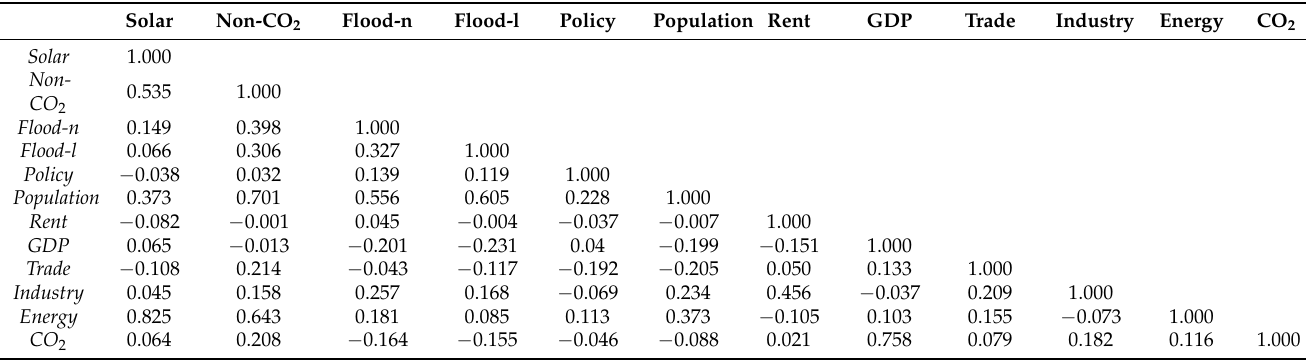
Table 4. Results of the correlation matrix of the